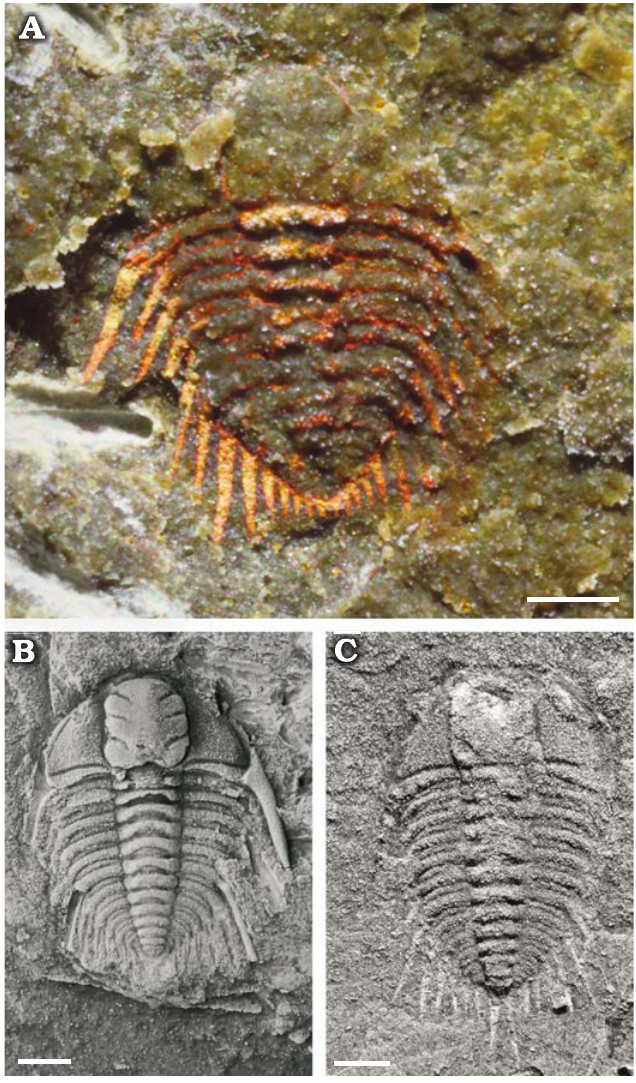
Fig. 3. Juveniles of the cheirurid trilobite Anacheirurus adserai from the Fezouata Shale, Araneograptus murrayi Zone, Tremadocian, Lower Ordovician, near Beni Zouli, Zagora Province, Morocco. A . MGL 104146, late meraspid stage. B . MGL 102153, early holaspid stage. C . MGL 104533, early holaspid stage. Specimens in B, C covered by ammonium chloride. Scale bars 1